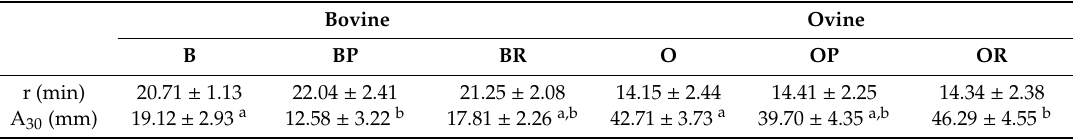
Table 5. E ff ect of microfiltration on milk clotting time (r) and curd firmness (A 30 ) of partially defatted bovine (B) or ovine (O) milk, bovine permeate (BP), bovine retentate (BR) (mean ± SD, n = 3), ovine permeate (OP) and ovine retentate (OR) (mean ± SD, n = 5). Bovine Ovine B BP BR O OP OR r